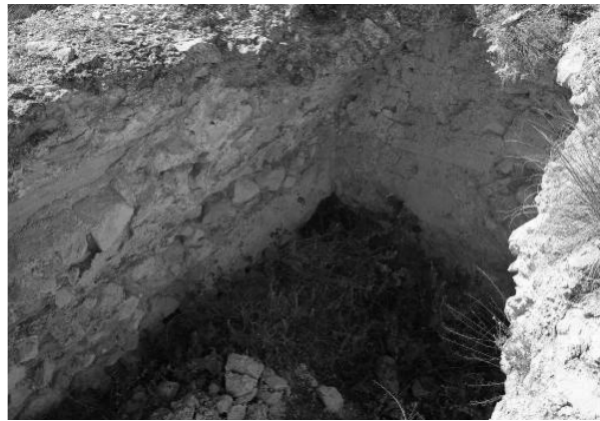
Figure 12. Upper cistern by Tower